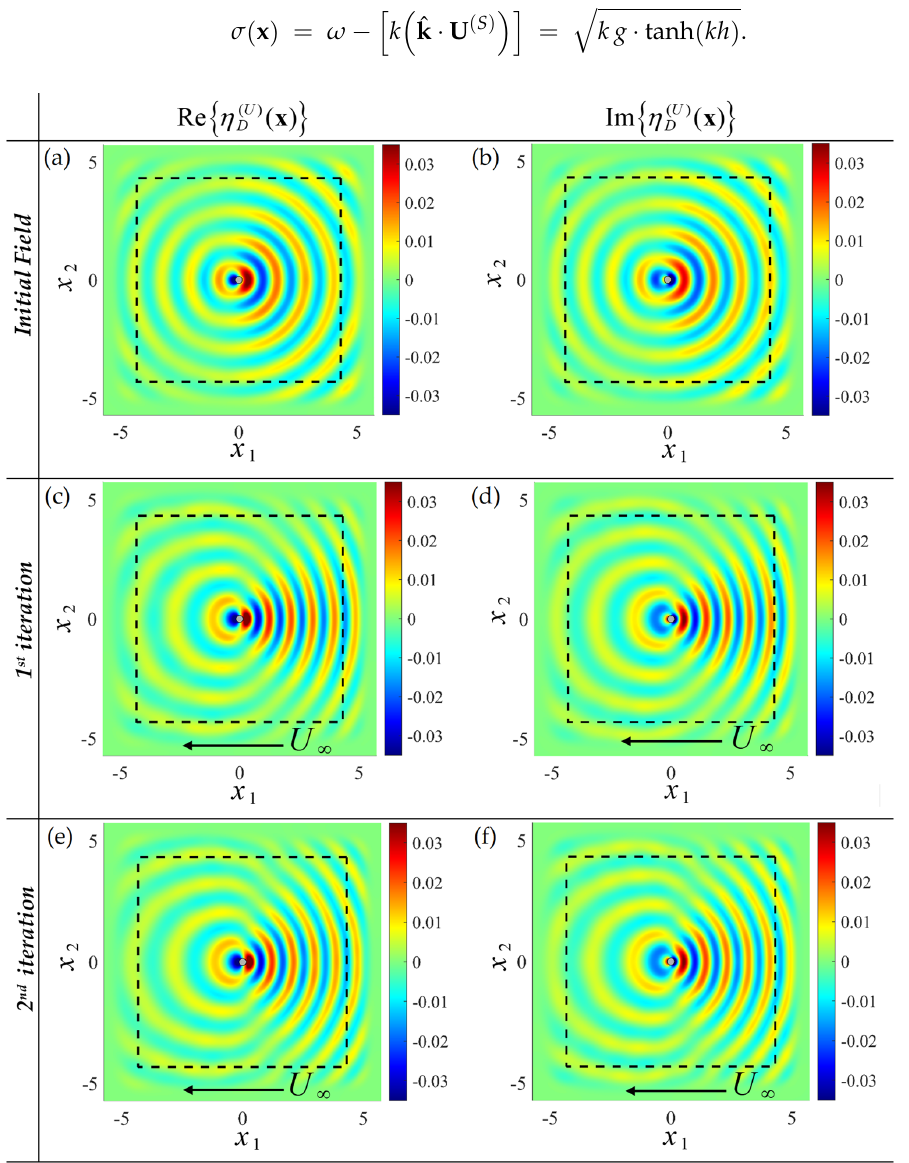
Figure 6. Incident waves of wavelength and height λ = 1.2m, H = 0.2m interacting with a vertical cylinder of diameter D = 0.3 m in water depth h = 1 m, in the presence of a parallel flow current U ∞ = ( − 0.3m/s,0,0 ) . ( a , b ) Imaginary and real part of the initial estimation of the disturbance field and corrected patterns after the first iteration ( c , d ) and after the second iteration ( e , f ), respectively. The dashed line indicates the absorbing layer region.